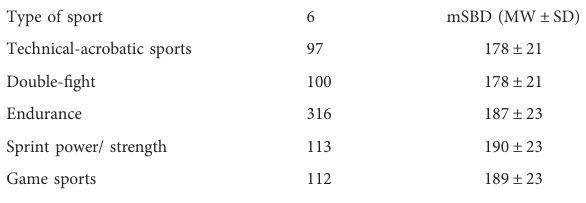
TABLE 5 In fl uence of sporting type.